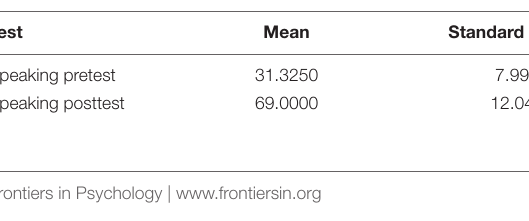
TABLE 1 | Mean scores of